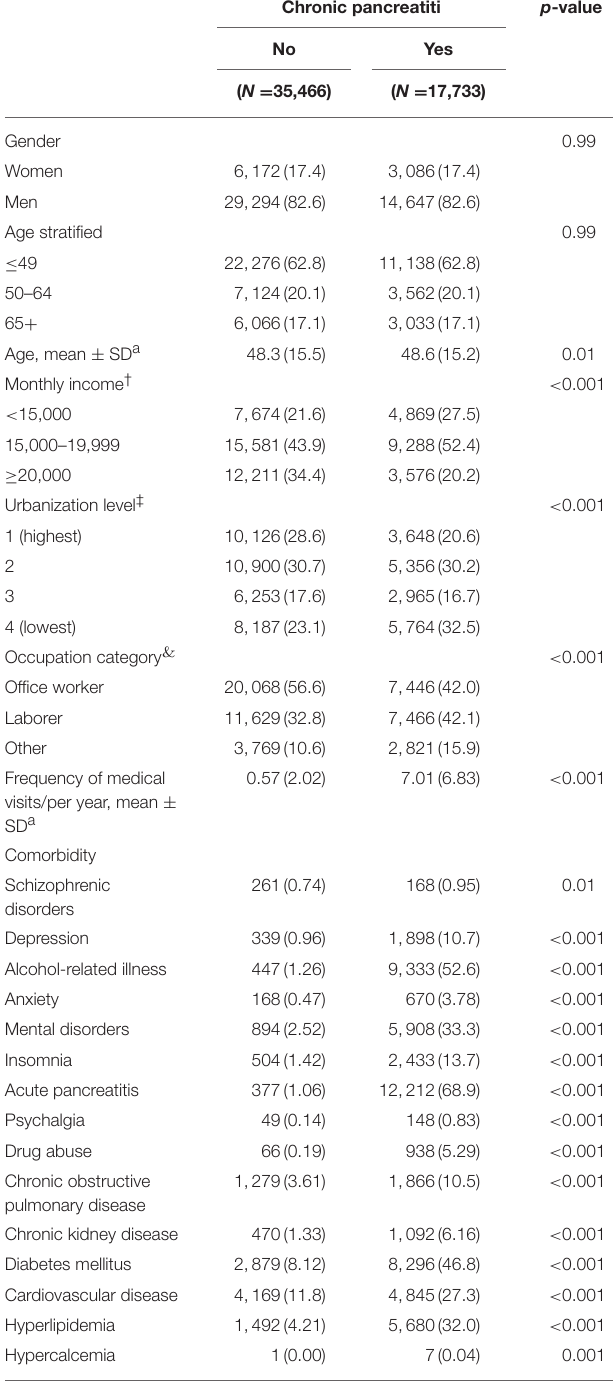
TABLE 1 | Comparisons of demographic characteristics and comorbidities in patients with and without chronic pancreatitis. Chronic